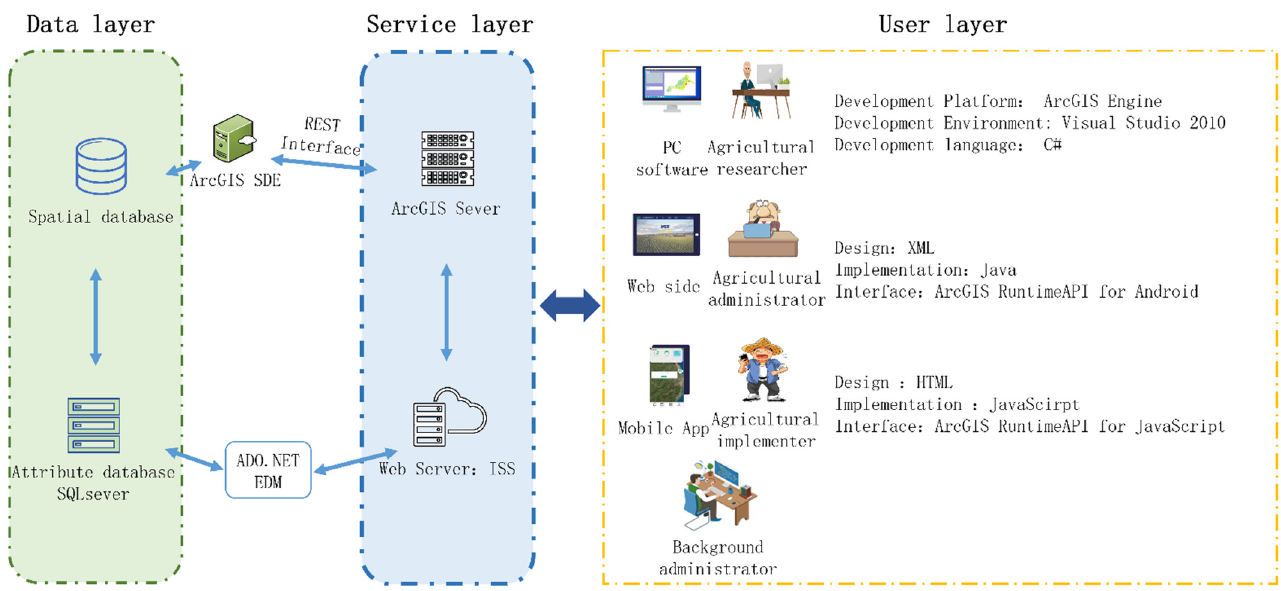
Figure 2. General architecture diagram of the platform.